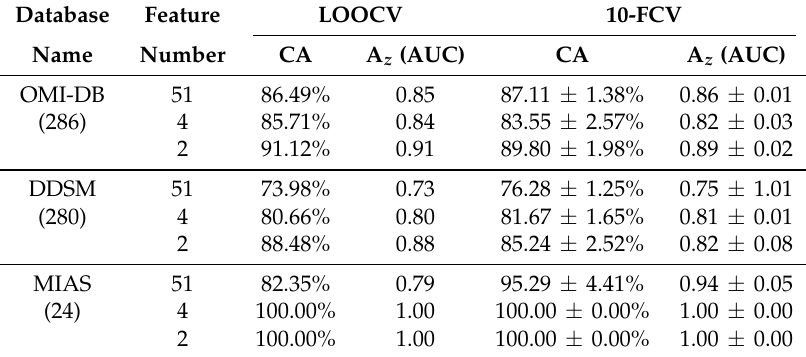
Table 4. Classification accuracy using LOOCV and 10-fold CV applying all 51 and the 2 most salient features from digital mammogram, and 4 most salient features from the digitized mammogram using ensemble learning. The images were segmented following the clinical grounding of cluster